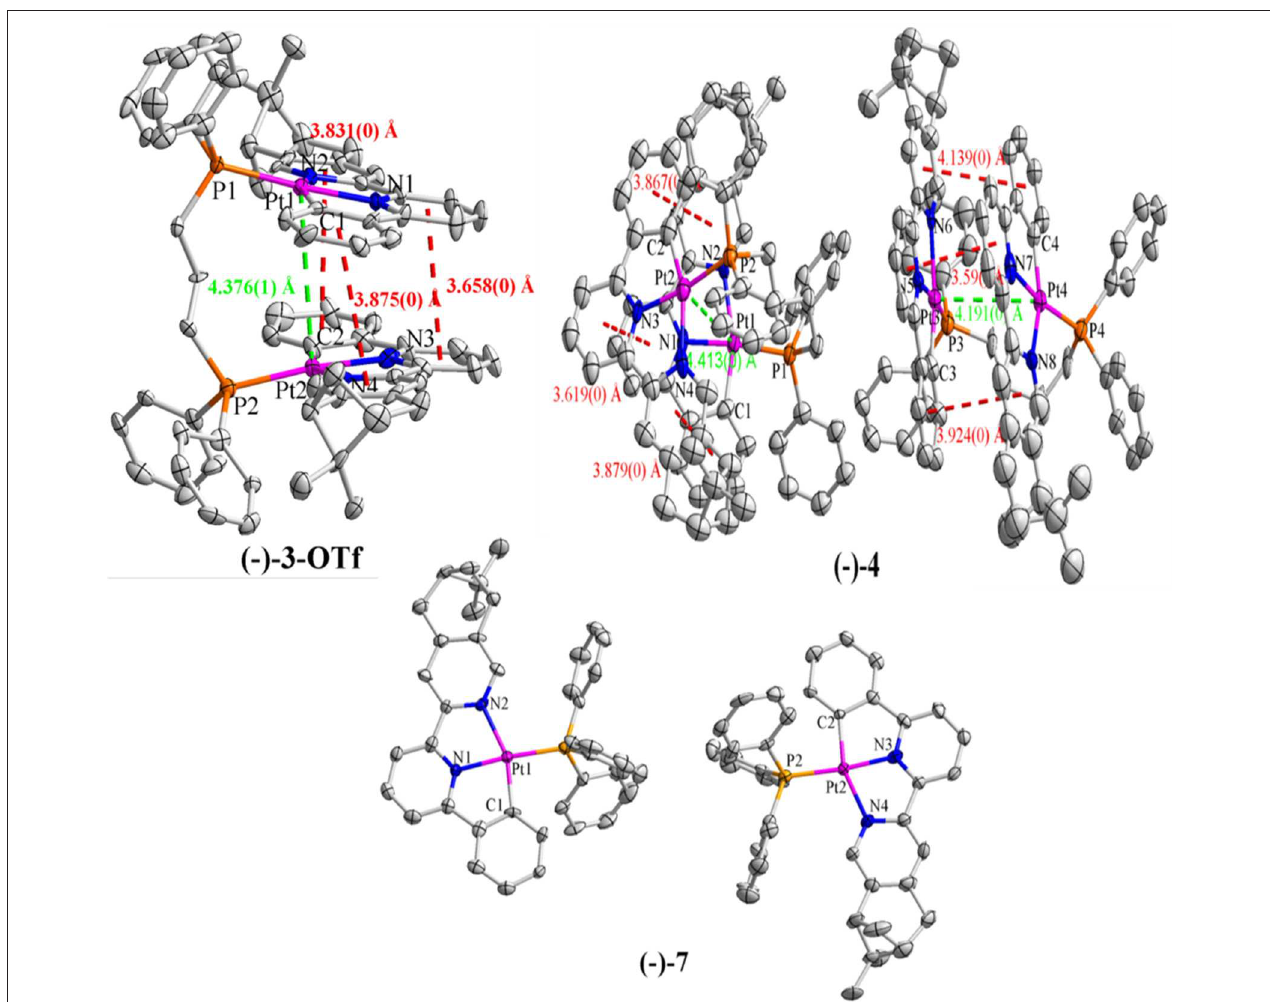
FIGURE 1 | X-ray crystal structures of (–)- 3 -OTf, (–)- 4 , and (–)- 7 , with the green dashed lines indicating the Pt ··· Pt distances and the red dashed lines indicating the π – π distances. H atoms, solvent molecules, as well as anions are omitted for clarity.